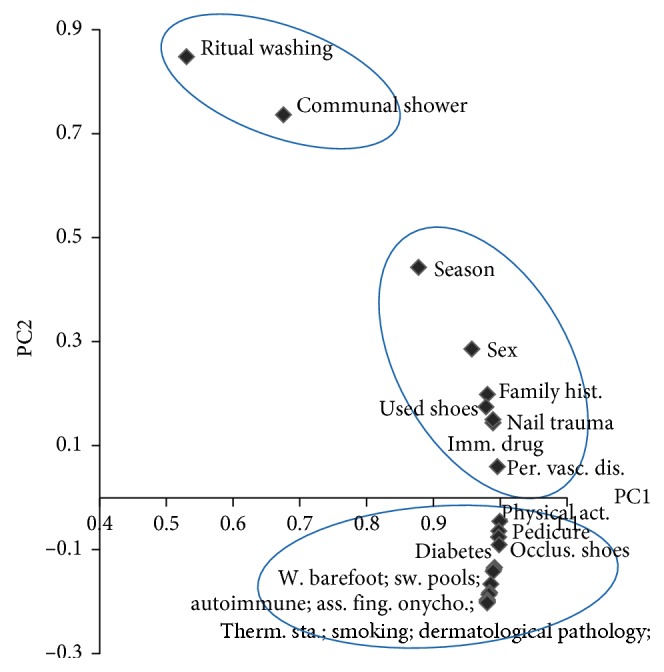
Principal components diagram of factors associated with foot mycosis.